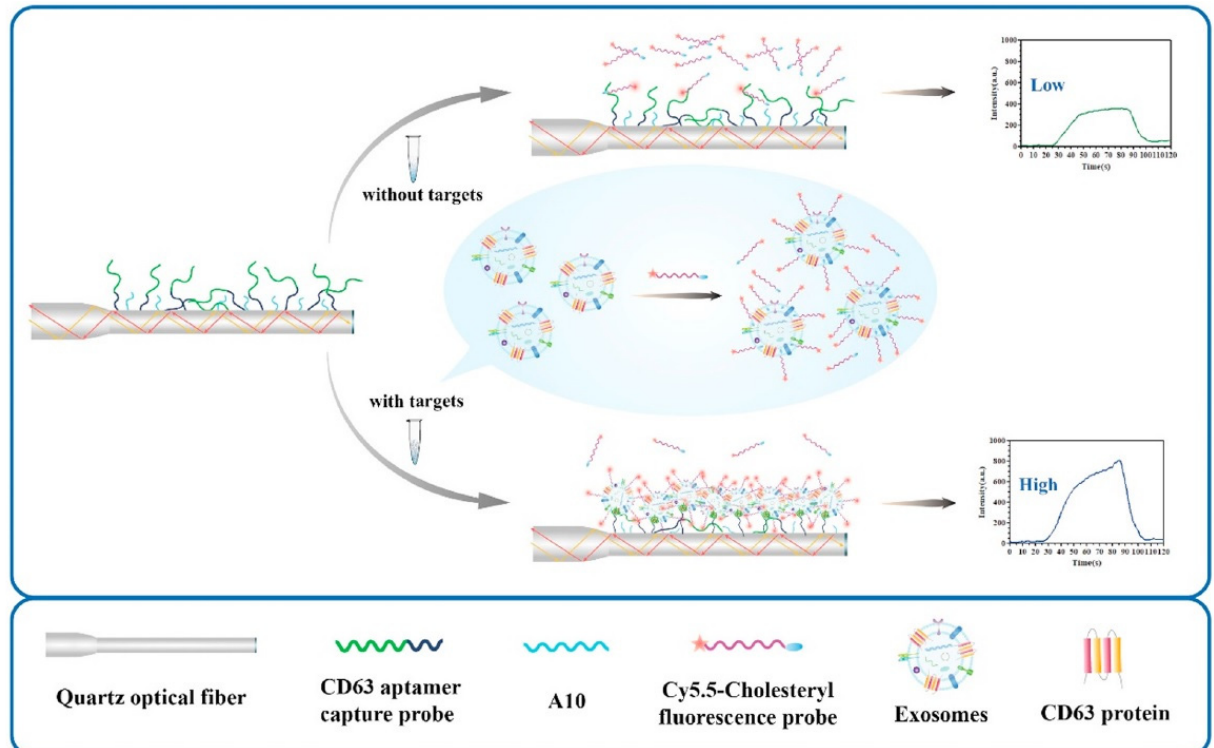
Figure 16. A sandwich-based sensing mechanism for exosome detection using FNA-FOEW sensor. Reprinted from Li et al. (2022) [117], Copyright (2022), with permission from Elsevier.